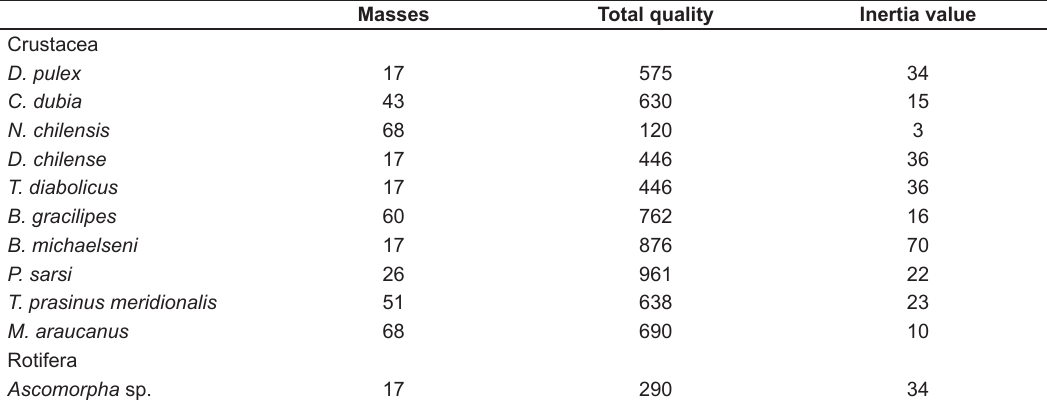
Figure 3. Graphs with simulated and observed species associations based on null model co-occurrence analysis for total species (up), rotifer species (center) and crustacean species (down). Table 5. Results of correspondence analysis for presence-absence species